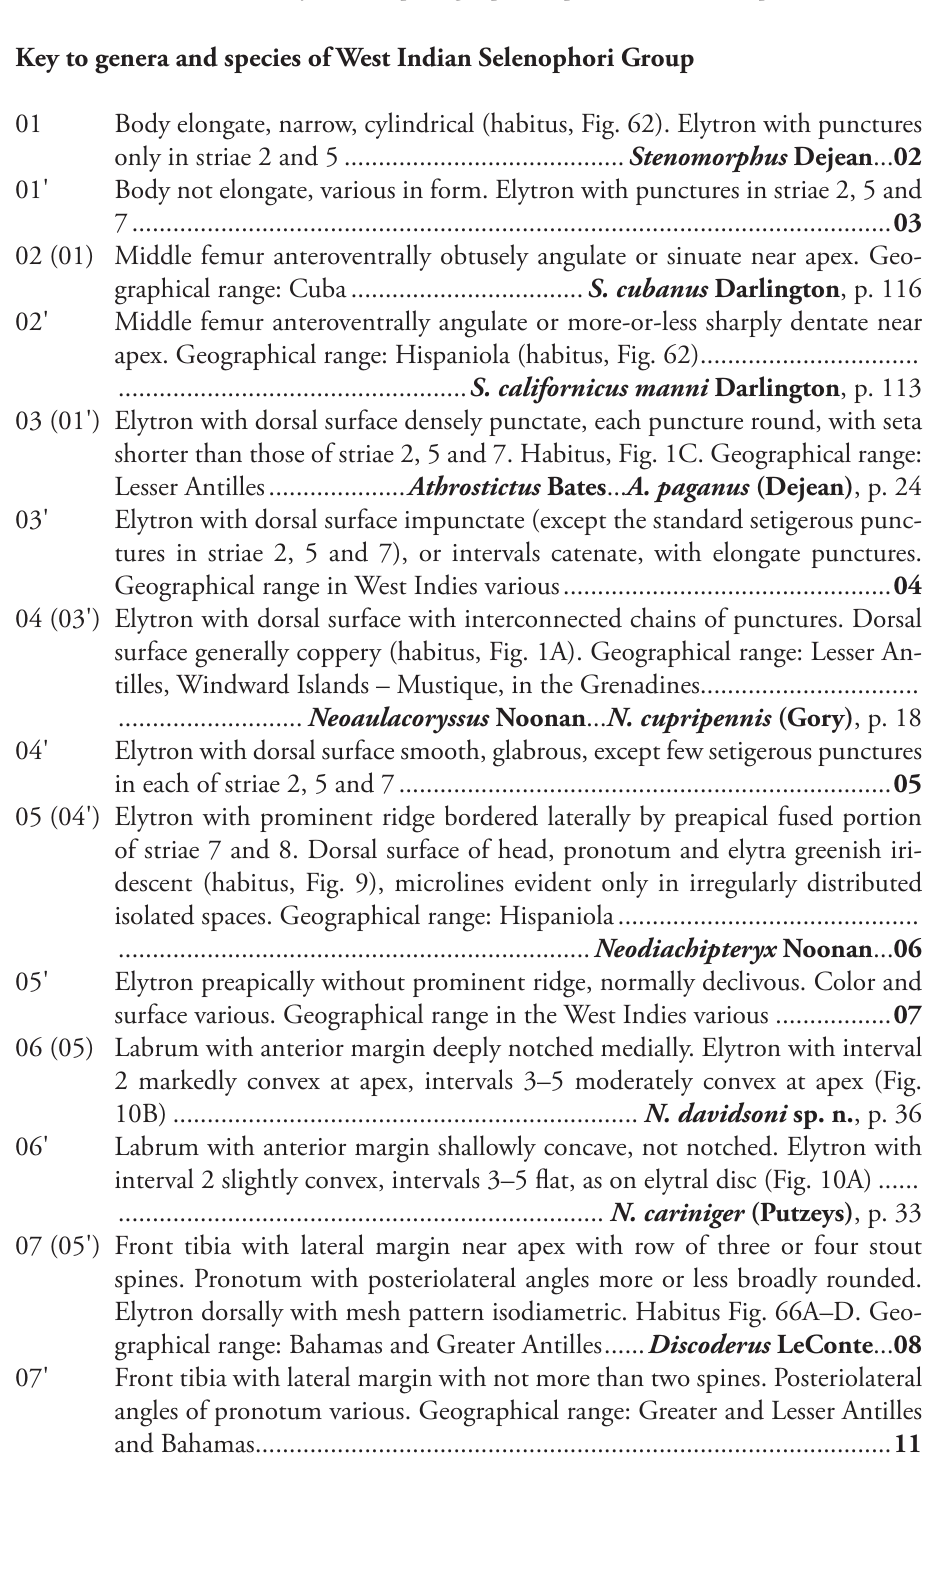
Key to genera and species of West Indian Selenophori Group 01 Body elongate, narrow, cylindrical (habitus, Fig. 62). Elytron with punctures only in striae 2 and 5 ......................................... Stenomorphus Dejean ... 02 01' Body not elongate, various in form. Elytron with punctures in striae 2, 5 and 02 (01) Middle femur anteroventrally obtusely angulate or sinuate near apex. Geo- 02' Middle femur anteroventrally angulate or more-or-less sharply dentate near